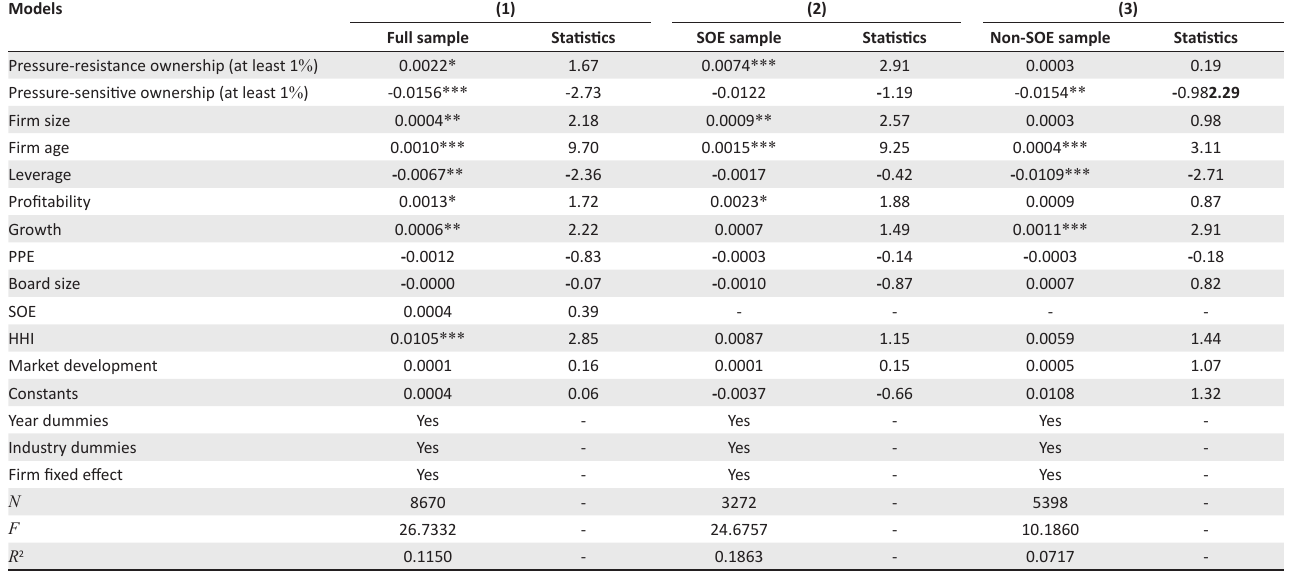
TABLE 3: The institutional investors and innovation input (research and development intensity).